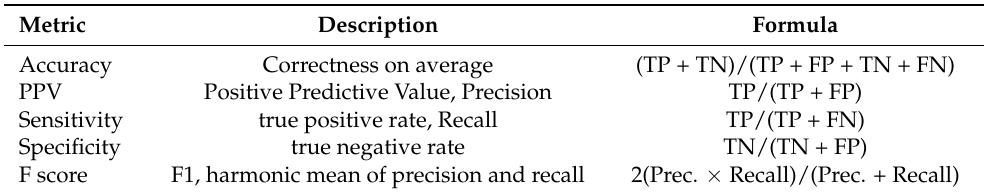
Table 1. Performance metrics. Precision (Prec). True positive (TP). False positive (FP). True negative (TN). False negative (FN).